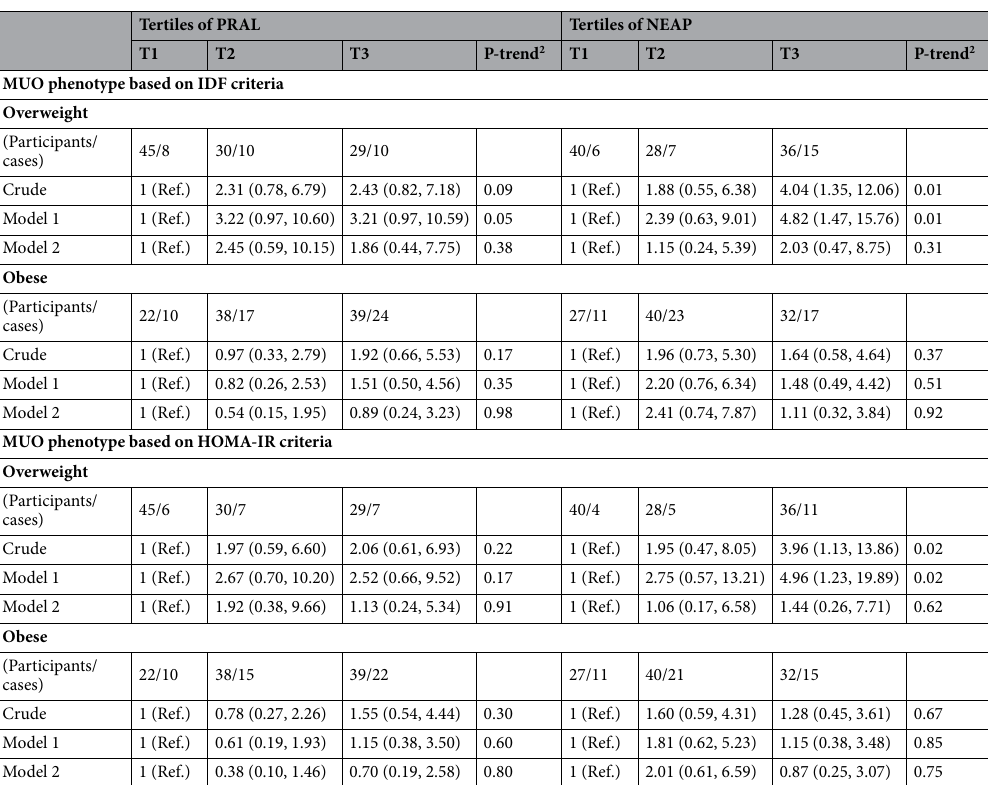
Table 4. Multivariate adjusted odds ratio (OR) and 95% confidence interval (CI) for MUO phenotype across tertiles of PRAL and NEAP, stratified by BMI categories 1 . 1 All values are odds ratios and 95% confidence intervals. Model 1: Adjusted for age, sex, and energy intake. Model 2: Additionally, adjusted for physical activity and socioeconomic status (evaluated based on parental education level, parental job, number of family members, having car in the family, having computer/laptop, having personal room and having travel by using demographic questionnaire). 2 Obtained by the use of tertiles of PRAL or NEAP as an ordinal variable in the